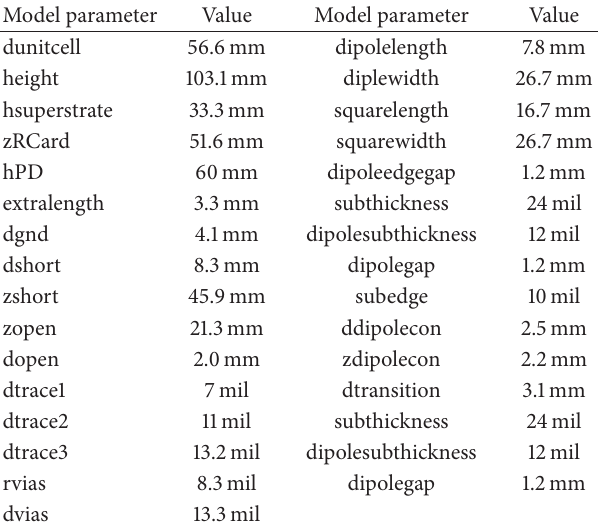
Table 1: Values of the all parameters used for the construction of the TCDA-IB array depicted in Figures